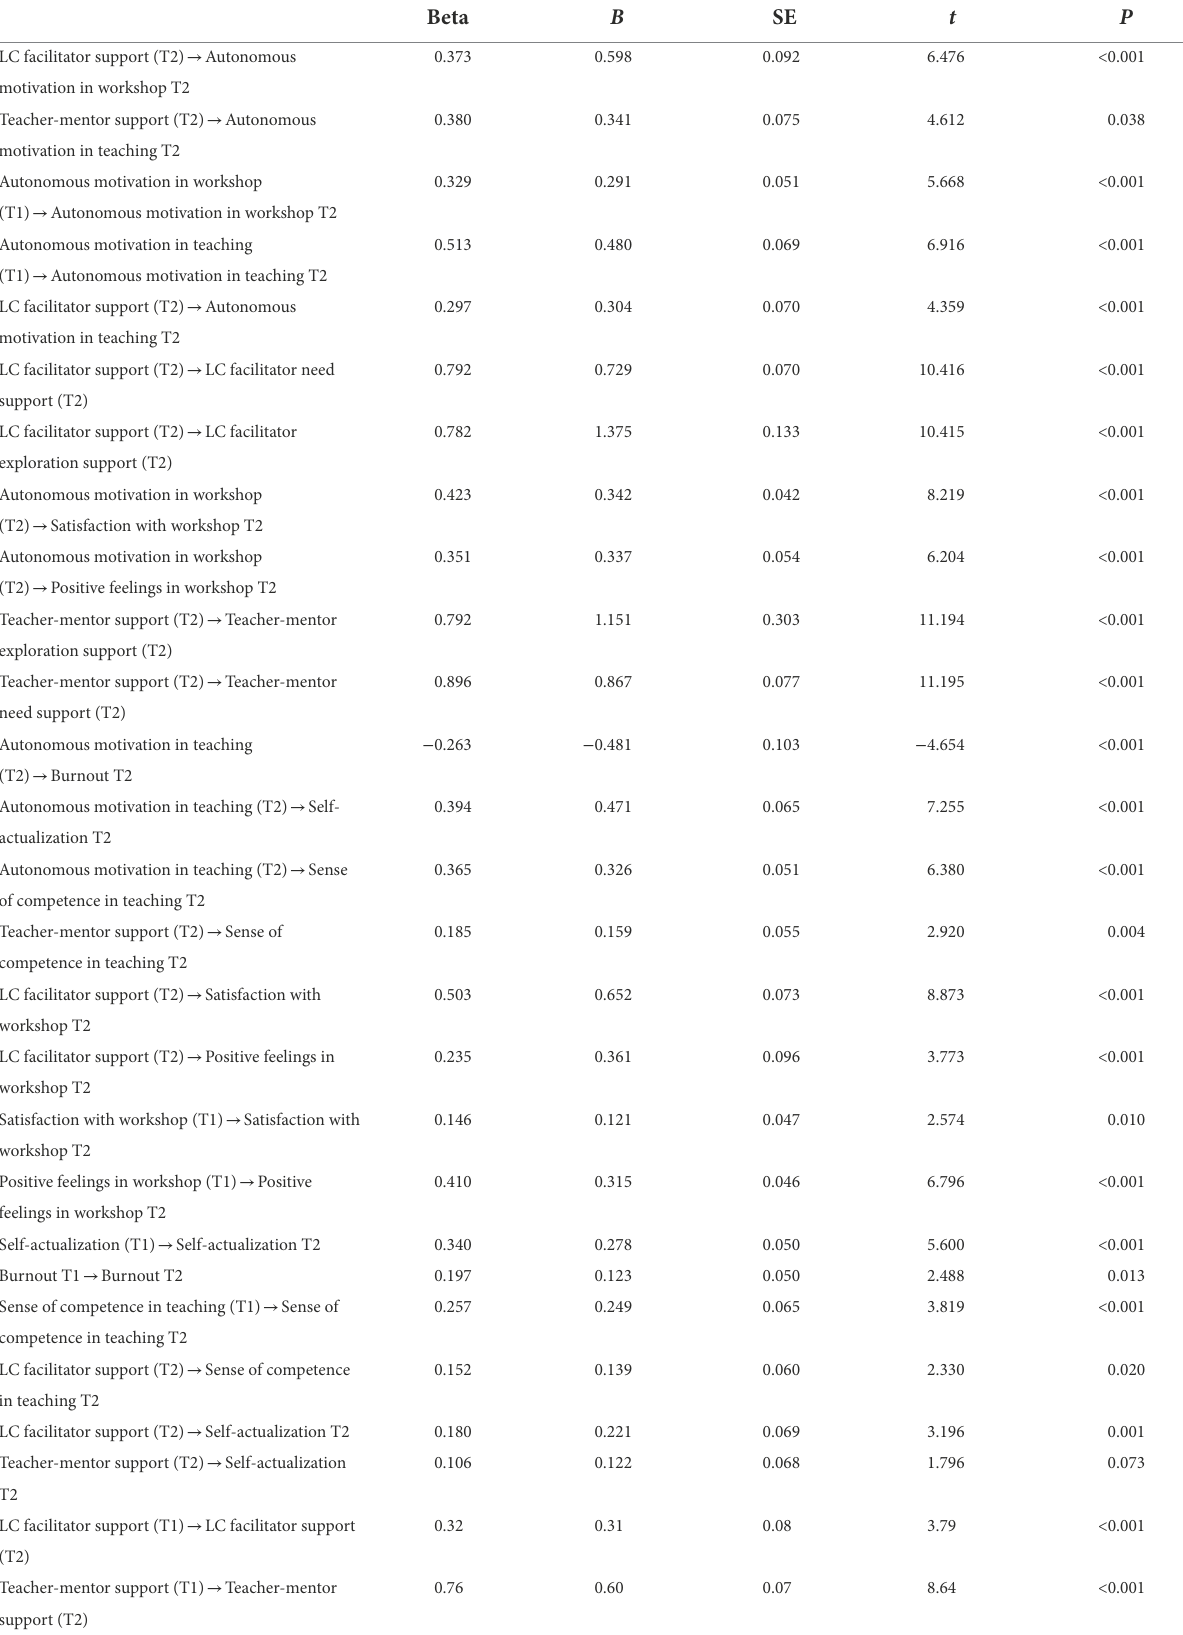
TABLE 5 Results of the mediation model with T1 and T2 variables. Beta B SE